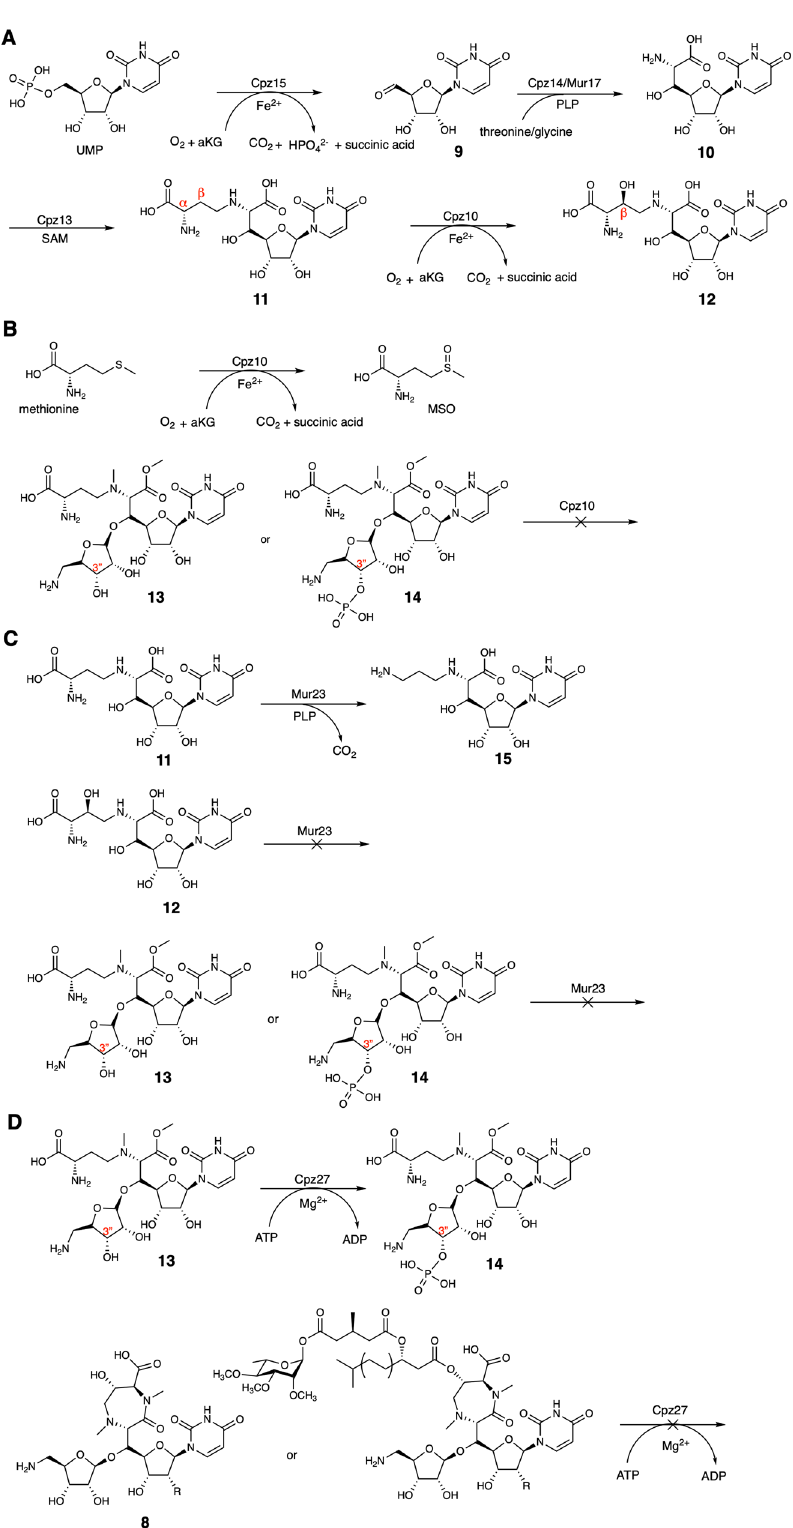
Fig. 2 Reaction scheme for selected enzymes referred to in this study. A Biosynthetic steps committed by Cpz15, Cpz14/Mur17, Cpz13 and Cpz10 in sequence. B Methionine or selenium can be oxygenated by Cpz10; compounds 13 or 14 cannot be accepted by Cpz10. C Compound 11 can be decarboxylated by Mur23 to compound 15 as opposed to compound 12 that cannot be consumed. D Compound 13 can be phosphorylated by Cpz27 to compound 14 , while compound 8 cannot be